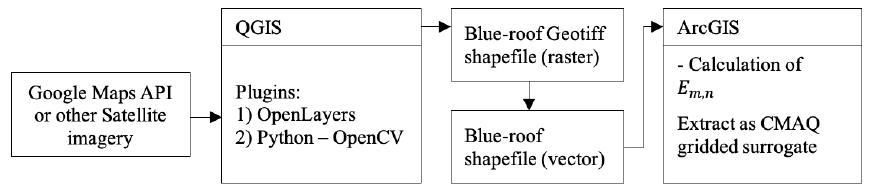
Figure 2. System flowchart for extract blue-roof industrial buildings.